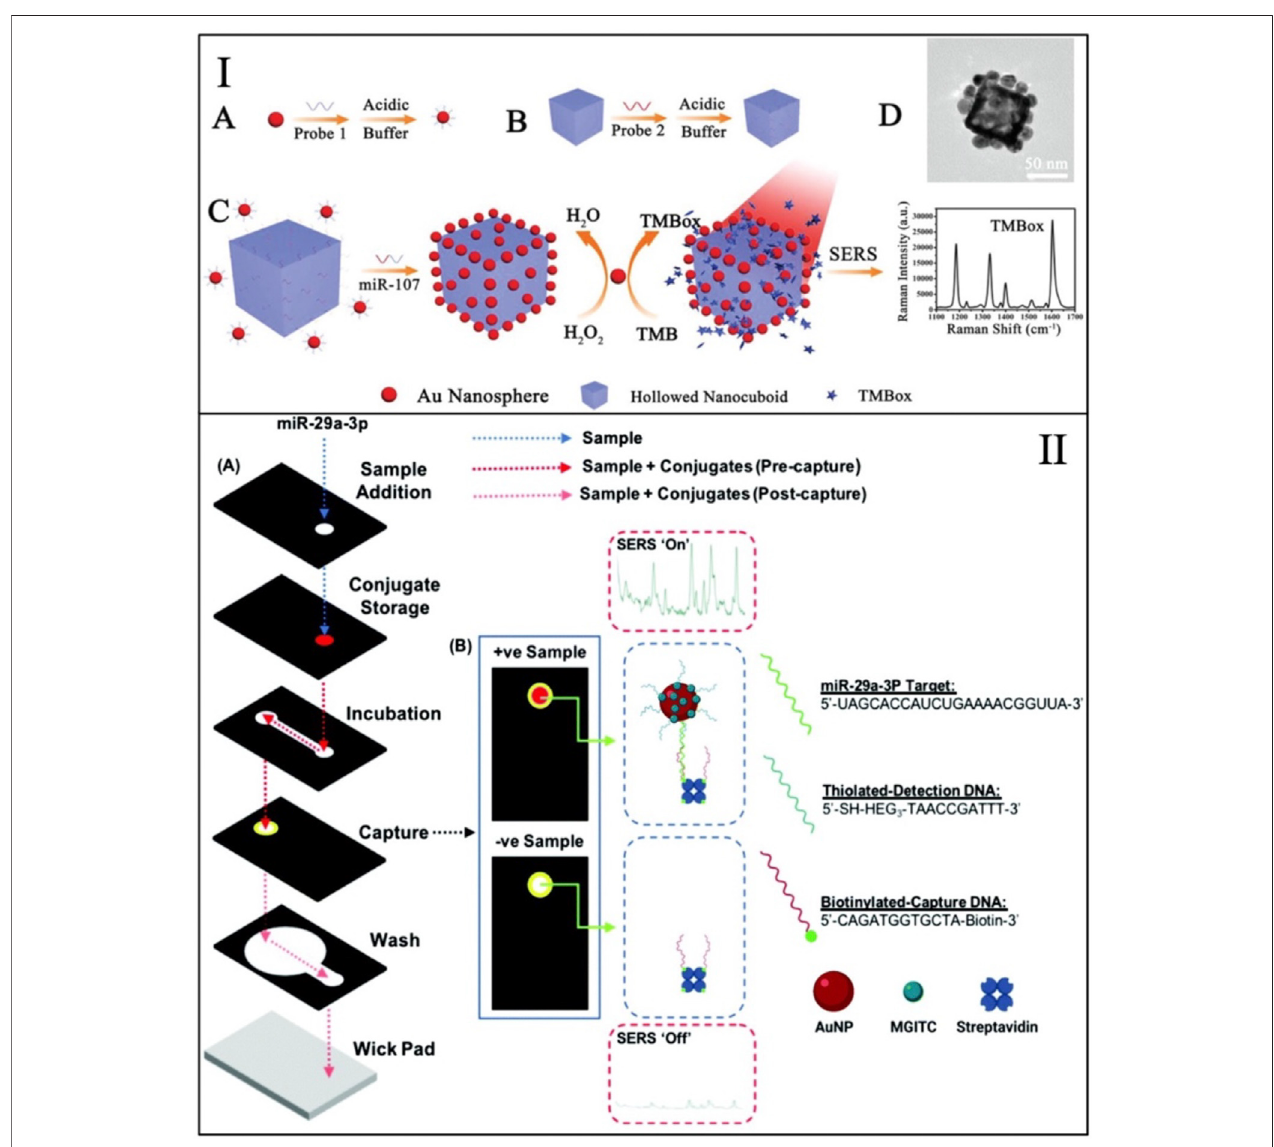
FIGURE1|(I) Schematicrepresentationofthebackground-freenanozymesensingmechanismforthedetectionofmiRNA--107.Adapted fromLietal.(2019). (II) Schematics of the 3D-paper fl uidic device used for the detection of miRNA-29. Adapted from Mabbott et al. (2020).